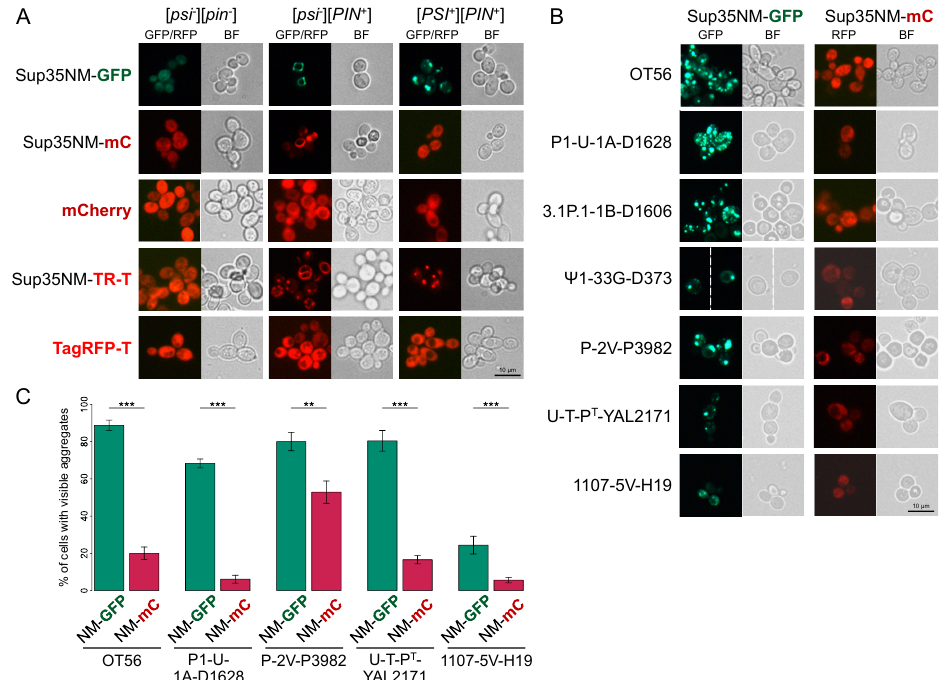
Figure 1. Fusion of Sup35NM to mCherry does not allow the detection of [ PSI + ] aggregates. Clones expressing copper-inducible constructs in OT56 ([ PSI + ][ PIN + ]), 1-OT56 ([ psi - ][ PIN + ]), 2-OT56 ([ psi - ][ pin - ]) ( A ), and other [ PSI + ] strains ( B ) were analyzed with fluorescence microscopy. Shown are representative images of either green (GFP) or red (RFP) fluorescence acquired using respective filter sets. Scale bar equals 10 µ m. Cells producing Sup35NM-mCherry and Sup35NM-TagRFP-T are henceforth denoted as Sup35NM-mC and Sup35NM-TR-T, respectively. ( C ). Quantification of the frequencies of the fluorescent foci detection in cells from B (see Supplementary Table S2 for the detailed cell count data). NM stands for Sup35NM. **, p < 0.01; ***, p < 0.001 in Fisher’s exact test. Error bars indicate percentage